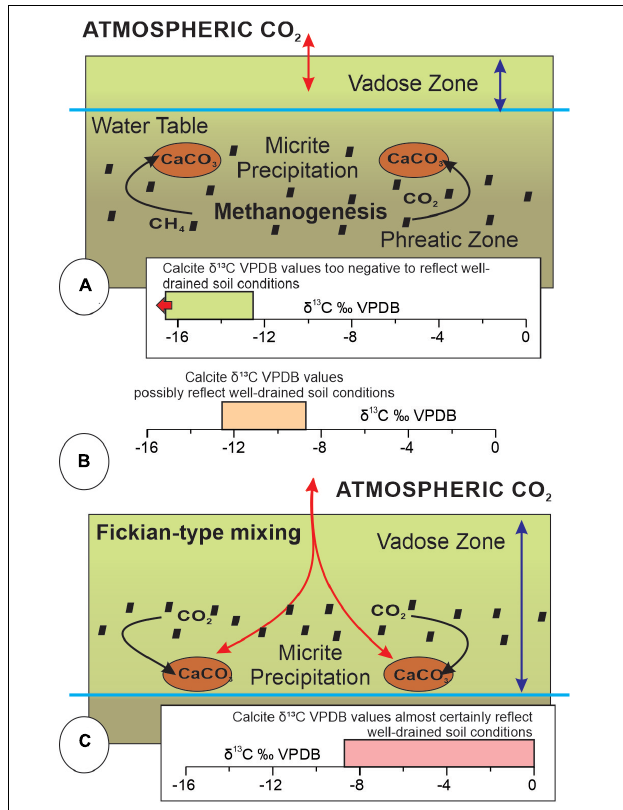
FIGURE 8 | End-member diagram showing the relationship between δ 13 C values of calcite cement in pedogenic nodules formed under closed and open systems. (A) δ 13 C VPDB values <